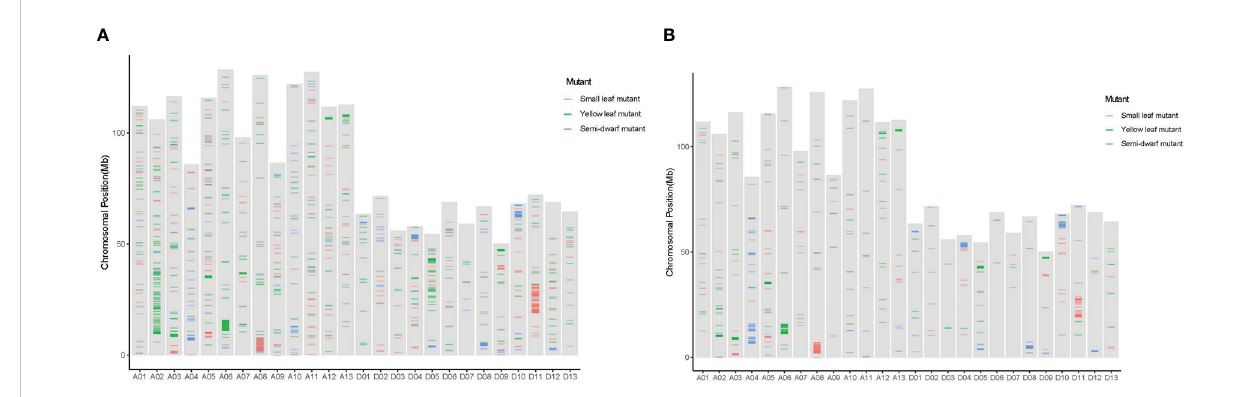
FIGURE 5 Distribution of SBS and InDels across all chromosomes mutations among three mutation lines. (A) The distribution of SBS mutations on each chromosome among three mutation lines. (B) The distribution of InDels mutations on each chromosome among three mutation lines.